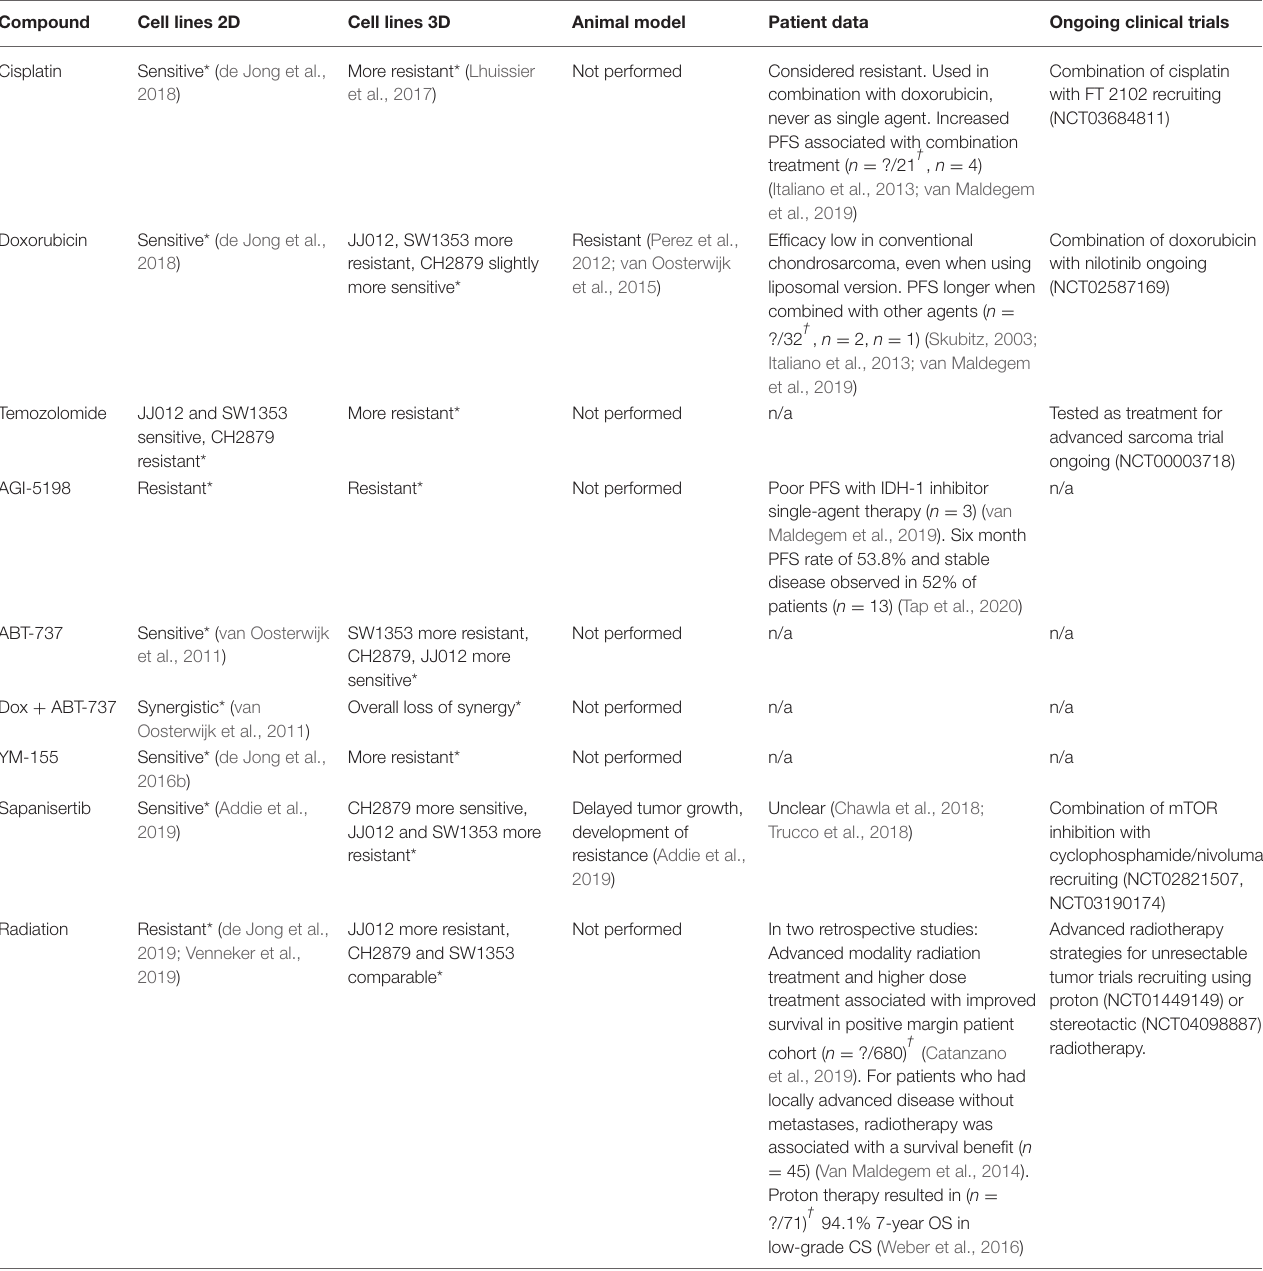
TABLE 2 | Summary of the sensitivity of 2D, 3D in vitro , mouse in vivo conventional chondrosarcoma models to selected chemo-/radio-/targeted therapies.